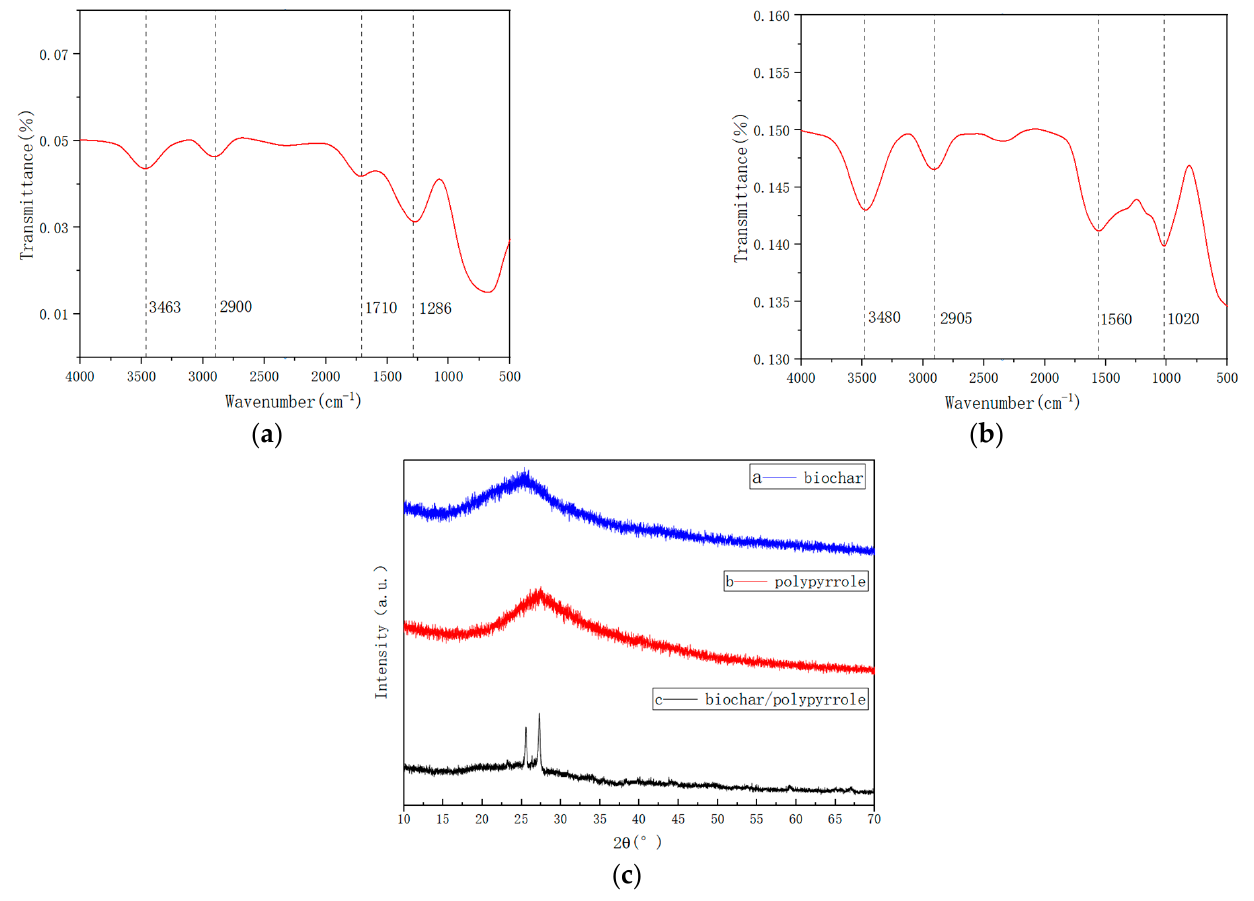
Figure 2. The infrared spectra of ( a ) biochar, ( b ) biochar/polypyrrole, ( c ) XRD analysis of a-biochar, b-polypyrrole, c-biochar/polypyrrole.